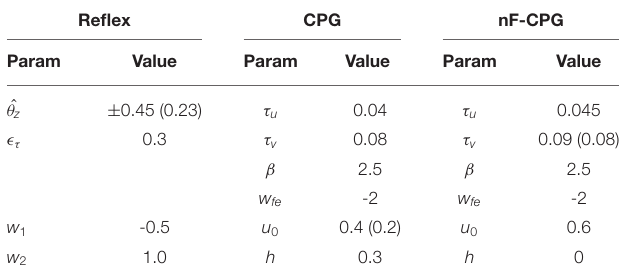
TABLE 1 | Parameter values used for the tested